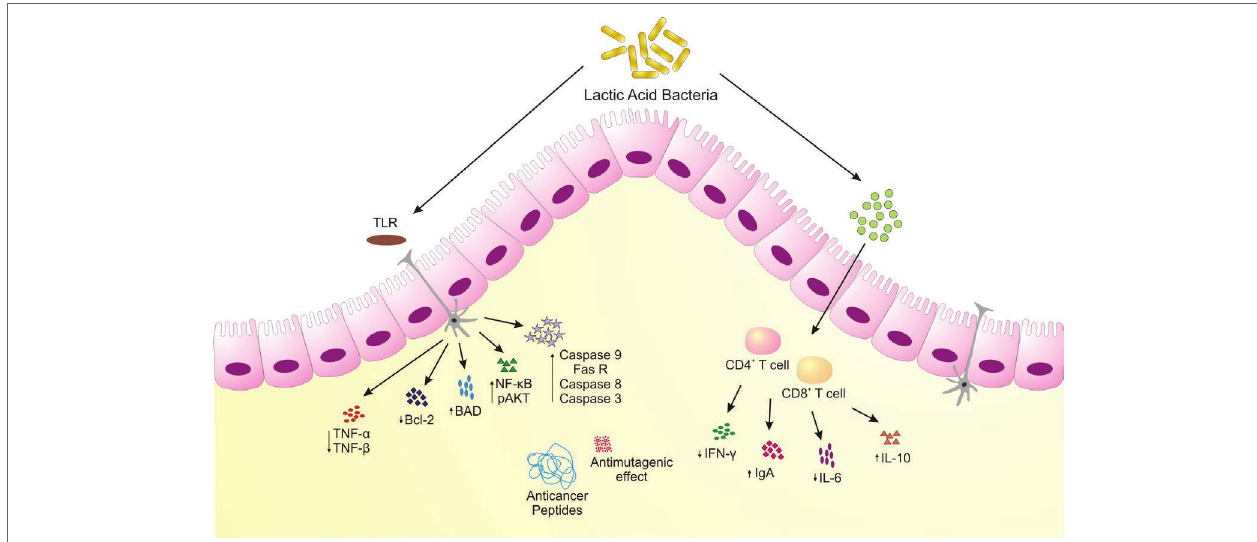
FIGURE 2 | Schematic representing anticancer attributes of microorganisms associated with traditional fermented milk foods. LAB induce apoptosis, increased anti-inflammatory cytokines, produce bioactive peptides to restrain colonic and colon-associated